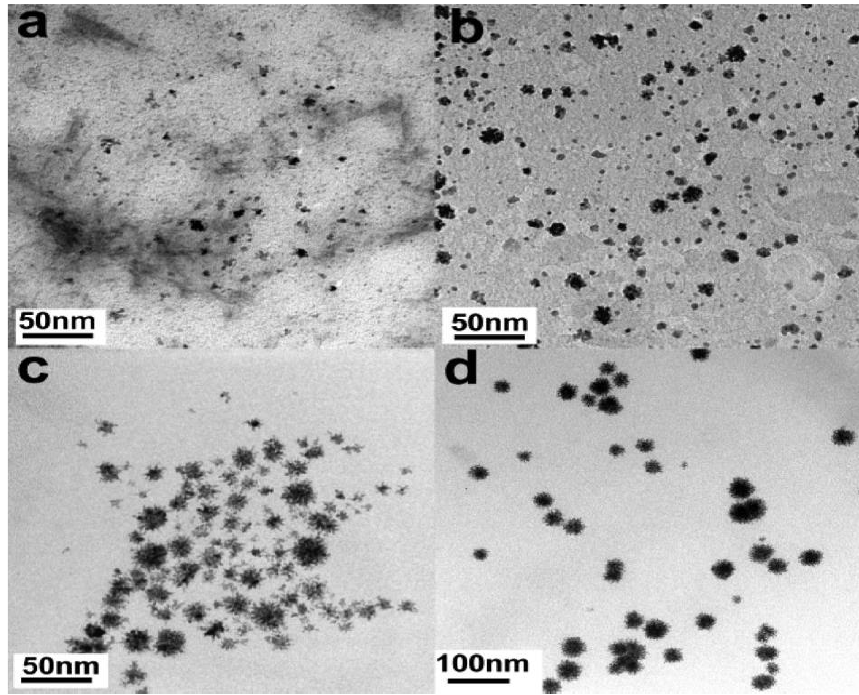
Figure 8. TEM images showing the time development of the dendritic Pt nanostructures (DPNs) synthesized using the sonoelectrochemical method after ( a ) 10, ( b ) 30, ( c ) 60 and ( d ) 90 min